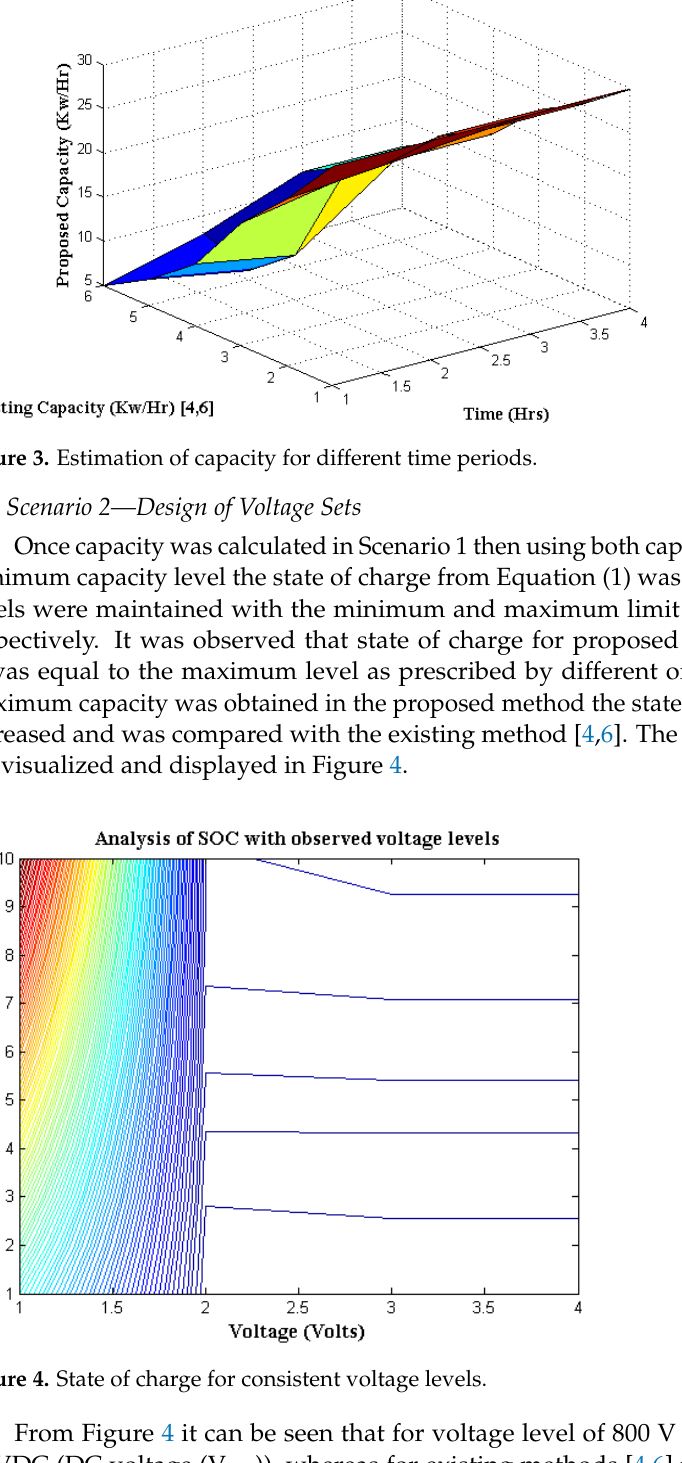
12 of 17 Figure 2. System architecture and wiring connection of proposed method. 4.1. Scenario 1 — Analysis of Capacity In this scenario the most important parameter for operating electric vehicles which was denoted as capacity was monitored (online), simulated (offline) and discussed. The capacity of battery changed from engine start time to complete running time and the main objective was to achieve high capacity on more successive time. Therefore, for exact analysis the electric vehicle was started at 8 AM with a maximum capacity of 30 kW/h and the test vehicle was kept running until it reached minimum capacity level. The ve- hicle was kept working for a period of 10 h and it was observed that level of capacity was monitored perfectly and it was found that for proposed method the level of capacity was reduced slowly and it operated for more time when compared with existing methods [4,6]. The results are visualized in MATLAB and are shown in Figure 3. From Figure 3 it can be seen that at starting time (8:00 AM) the capacity was 30 kW/h and for a period of 2 hours the capacity was decreased to 26 kW/h and finally after 10 h it reached to 12 Kw/hr. However, for existing methods [4] after 2 hours the capacity was reduced to 24 kW/h and after 10 h it reached 5 Kw/hr. Similarly, for Reference [6] after 2 hours the capacity was reduced to 25 kW/h and after a certain gap it reached 8 Kw/hr.